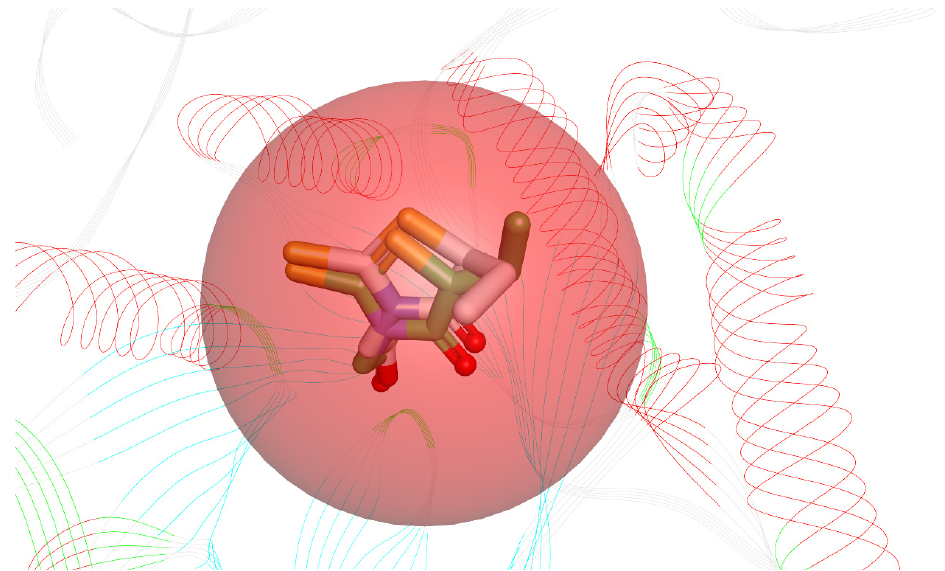
Figure 3. Superimposed bioactive structure of epalrestat bound in the binding pocket of ALR-2 (PDB ID: 4JIR) (green stick model) and the docked epalrestat (grey stick model) with an RMSD of 0.89 Å. The top four selected natural compounds well aligned with the generated pharma- cophore (Figure 4) were prepared for docking using “Prepare ligand” protocol from DS and were energy minimized.